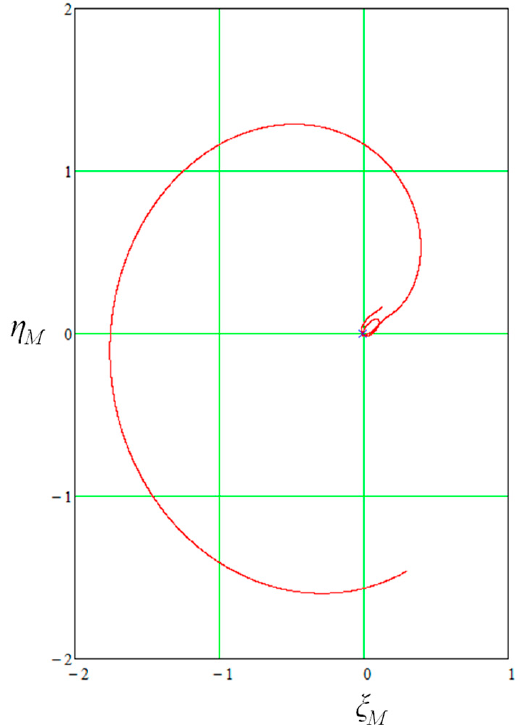
Figure 19. The trajectory of the spacecraft movement corresponding to the “circumlunar” segment (starting from time t 1 to t 1 + (cid:101) ∆ t f ). Represented in the coordinate system ξ M C η M ( ζ ) with axes fixed in inertial space (center C coincides with the Moon) (see Appendix B), the direction of the main axis of which at the initial moment of time coincides with the direction to the Sun.